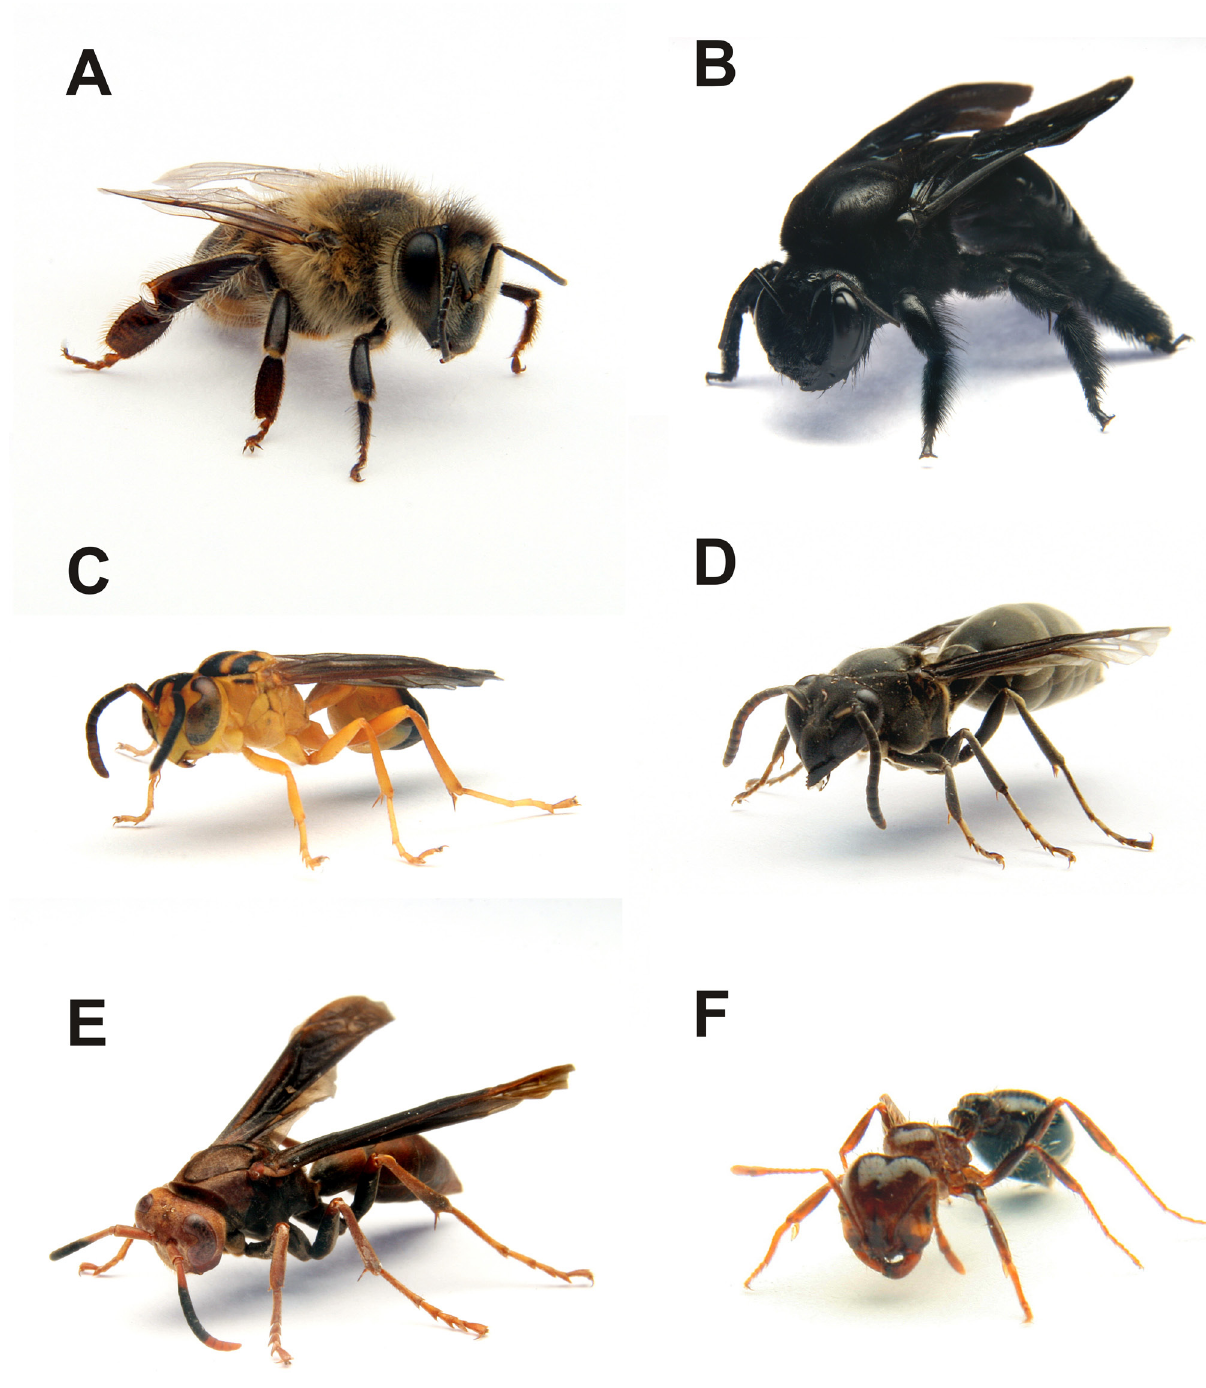
Figure 1. Workers of some Brazilian Hymenoptera insects: ( A ) Africanized Apis mellifera bee; ( B ) Bombus sp. bee; ( C ) Agelaia pallipes pallipes wasp; ( D ) Polybia ignobilis wasp; ( E ) Polistes lanio lanio wasp; ( F ) Solenopsis invicta ant (photos by Martelli